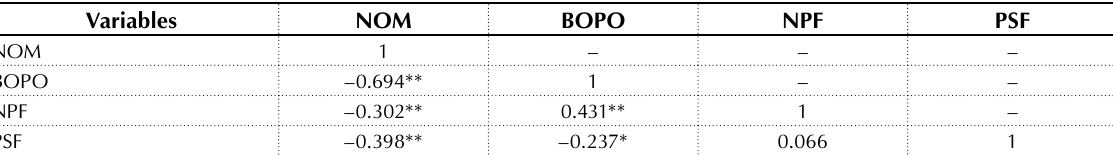
Table 2. Pearson correlation matrix for main